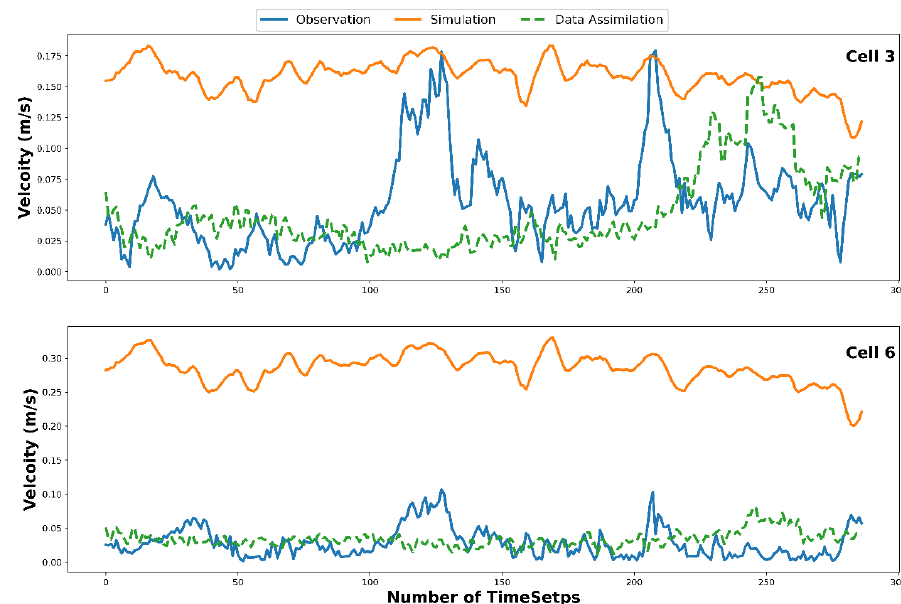
Figure 10. Comparison of the simulated (orange solid line), observed (blue solid line), and assimilated (green dotted line) flow velocity during assimilating period.